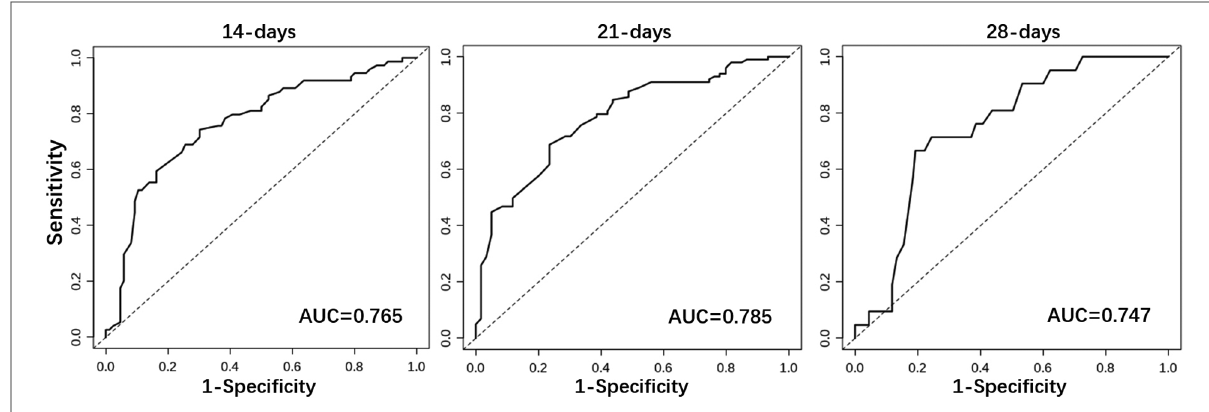
FIGURE 2 The ROC curves of prediction model in week 2, week 3 and week 4.